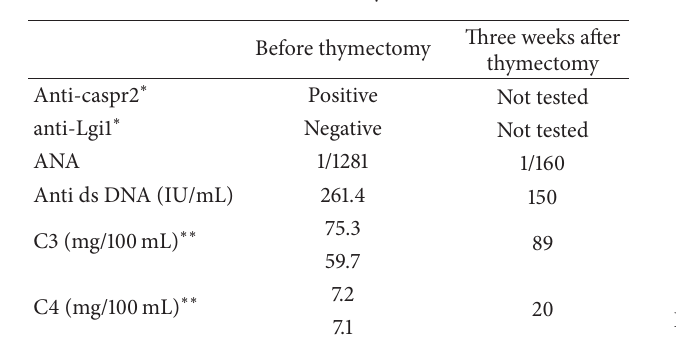
Table 1: Laboratory results.